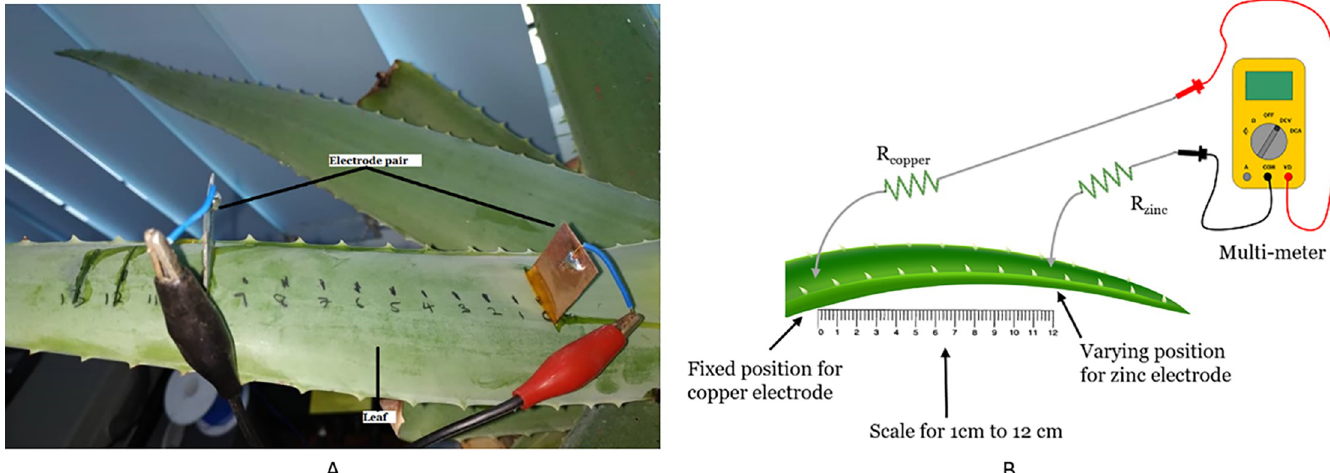
Fig 2. Experiment setup for variation of distance between electrodes. Example of setup arrangement (A) and simple schematic of the setup (B).